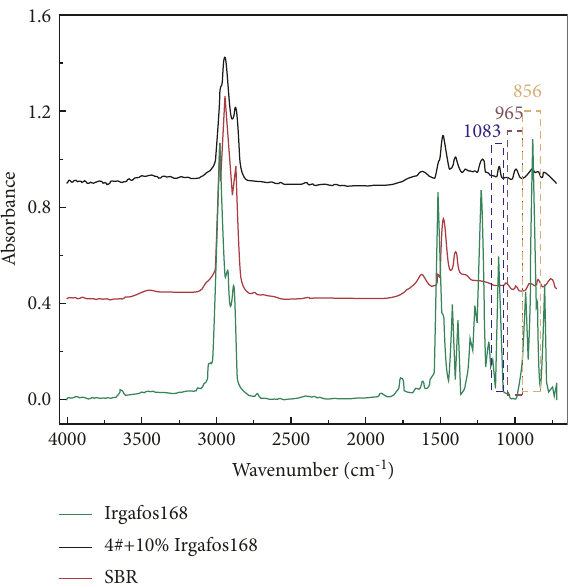
Figure 11: Spectra of Irgafos 168, SBR-modified asphalt, and 4# +10%Irgafos 168.